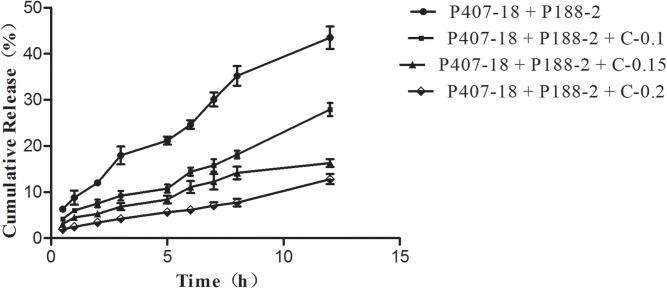
Release profiles of APS for the first 12 h from in-situ forming gel formulations containing CMC-Na with different concentrations in PBS at 37°C (n = 3; error bars were omitted for clarity).